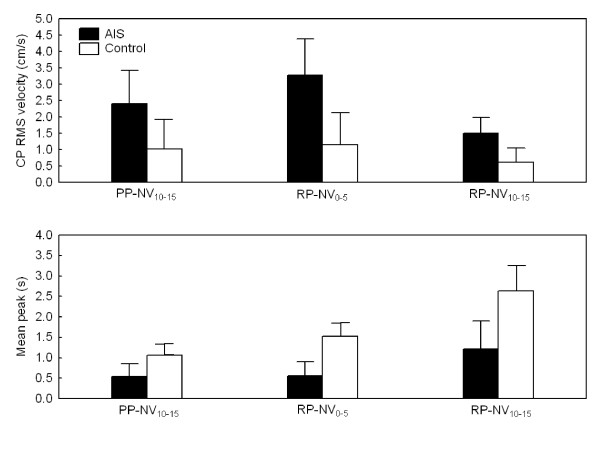
Balance control performance during reintegration of ankle proprioception in absence of vision. Upper panel presents the interaction Group by Epoch for the CP RMS velocity for the last 5 s epoch of sensory deprivation interval (PP-NV10–15 perturbed proprioception/no-vision) and for the first and last 5 s epoch of the sensory reintegration interval (RP-NV0–5 and RP-NV10–15 reintegration proprioception/no-vision condition). Lower panel illustrates the interaction Group by Epoch for the time spent within the zone of stability for the same 5 s epochs as the upper panels. On all panels, the error bars indicate 95% confidence interval.